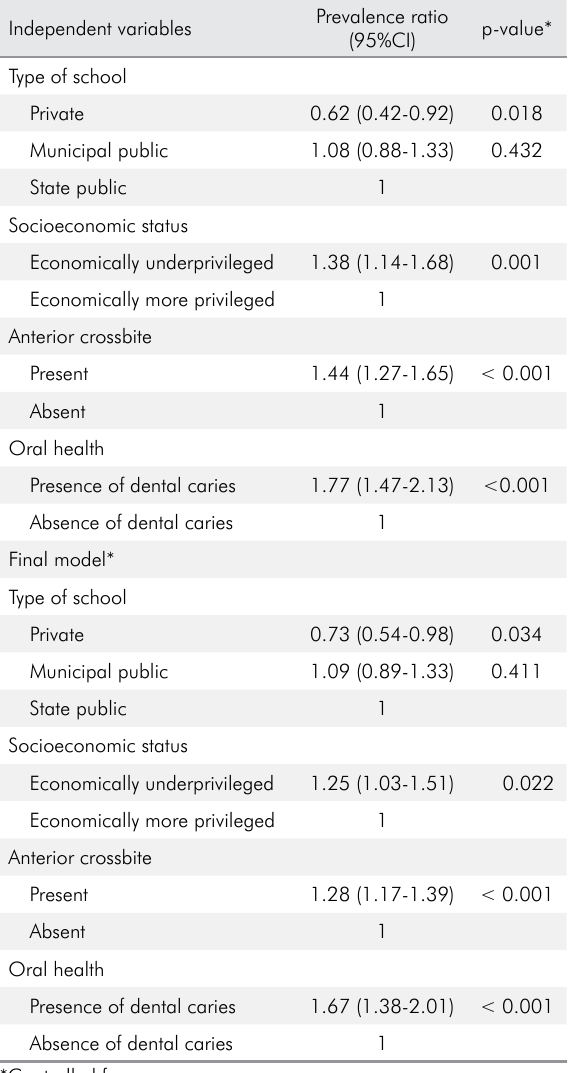
Table 5. Hierarchical Poisson regression analysis of the impact on oral health related quality of life (CPQ variables (n=390); Diamantina, Brazil,